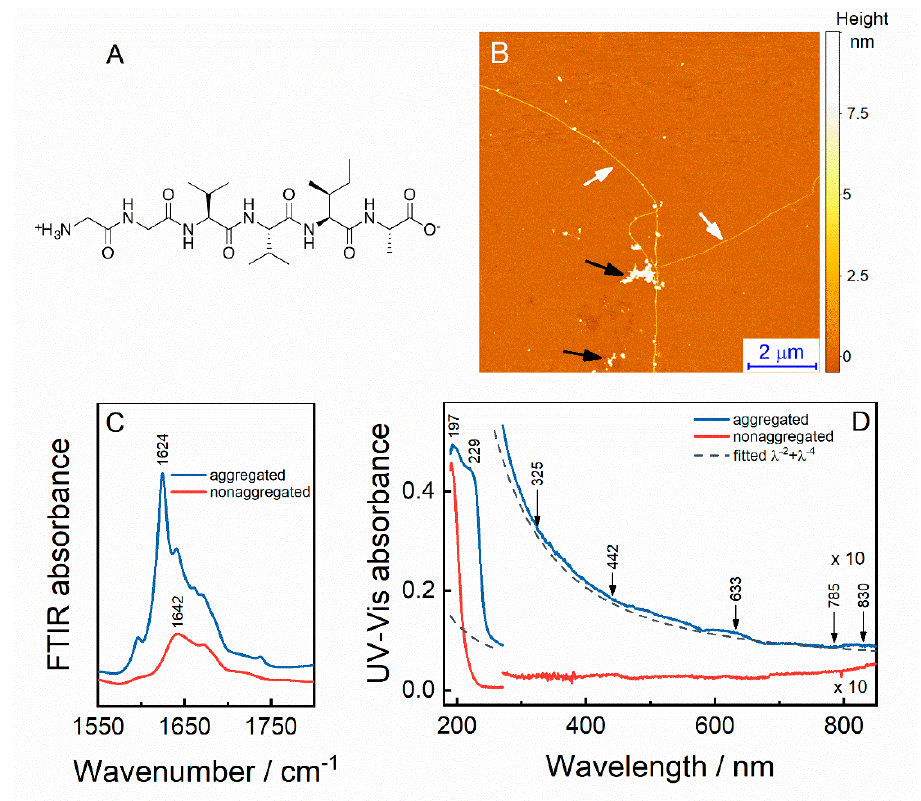
Figure 1. Molecular structure of amyloid- β -(37–42) motif, the GGVVIA ( A ). AFM image of aggregated GGVVIA peptide deposited on mica. Black arrows indicate peptide oligomers and white arrows indicate fibrils ( B ). FTIR spectra of aggregated (10 mg / mL) and non-aggregated (5 mg / mL) GGVVIA peptide in the amide I’ absorption region recorded in D 2 O solution ( C ). UV–Vis spectra of aggregated (10 mg / mL) and non-aggregated (0.01 mg / mL) GGVVIA peptide ( D ). Arrows indicate the wavelengths of laser radiation used in this study.